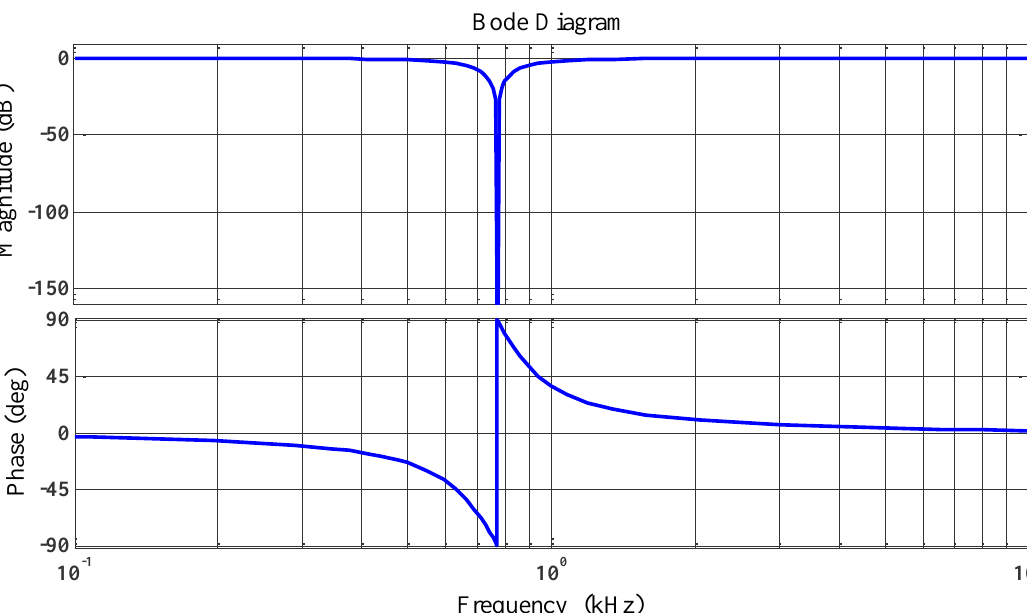
Figure 14. Frequency response for RLC notch